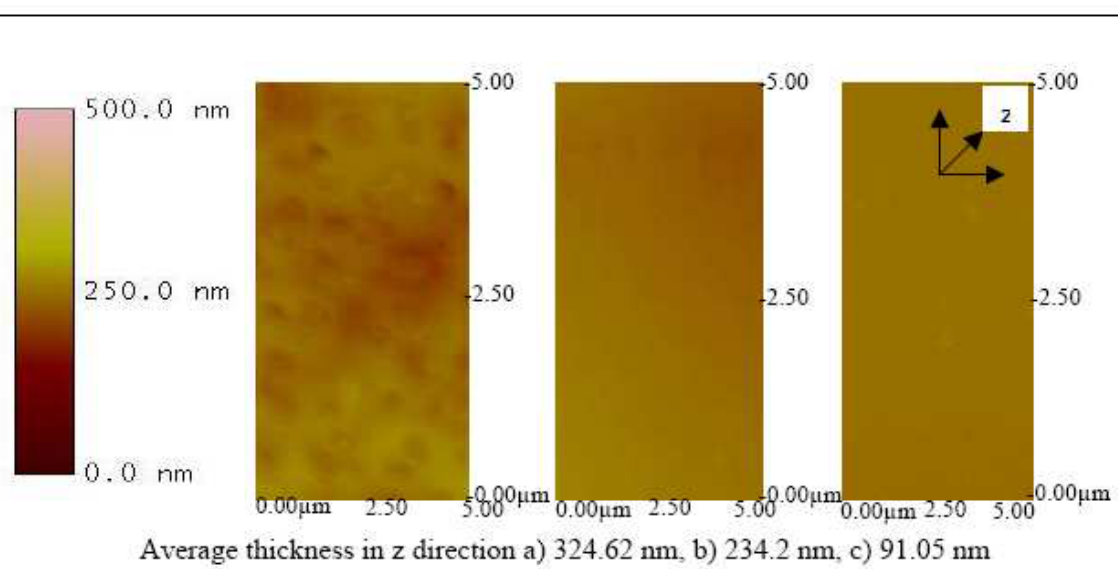
Figure 10. Atomic force microscopy images of a) ITO glass treated with (NH with 65KDa, b) 50KDa, c) 20KDa